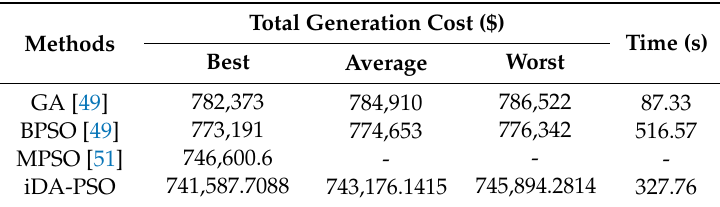
Figure 5. Convergence curve of the iDA-PSO approach for the 26-unit system. Table 14. Simulation results of the iDA-PSO approach compared with other algorithms for the 26-generating unit system.